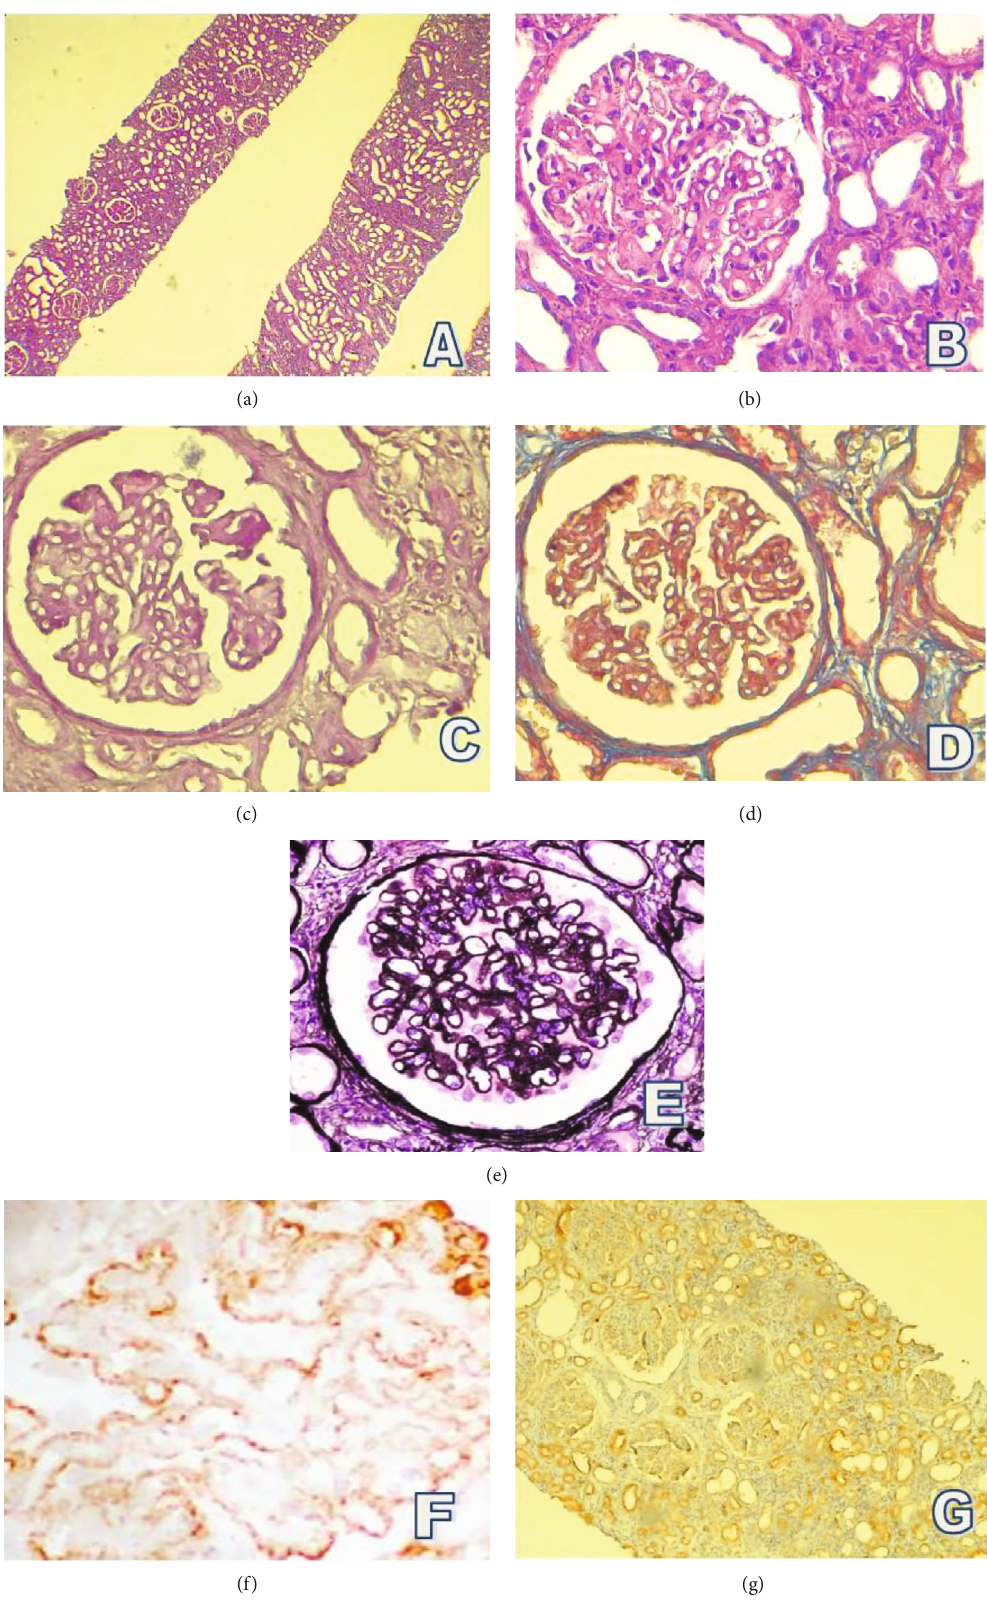
Figure 1: Renal allograft biopsy. (a) 40x hematoxylin and eosin (HE) stains with no apparent IF/TA, (b) 100x HE, (c) Periodic acid – Schi ff ( PAS ) stain, (d) Masson trichrome stain, and (e) Methenamine silver stain . All (c) – (e) reveal thickened glomerular basement membrane and spikes. Immunohistochemistry (IHC) shows a granular IgG deposit (f), and it is negative for C4d, SV40, and PLA2R